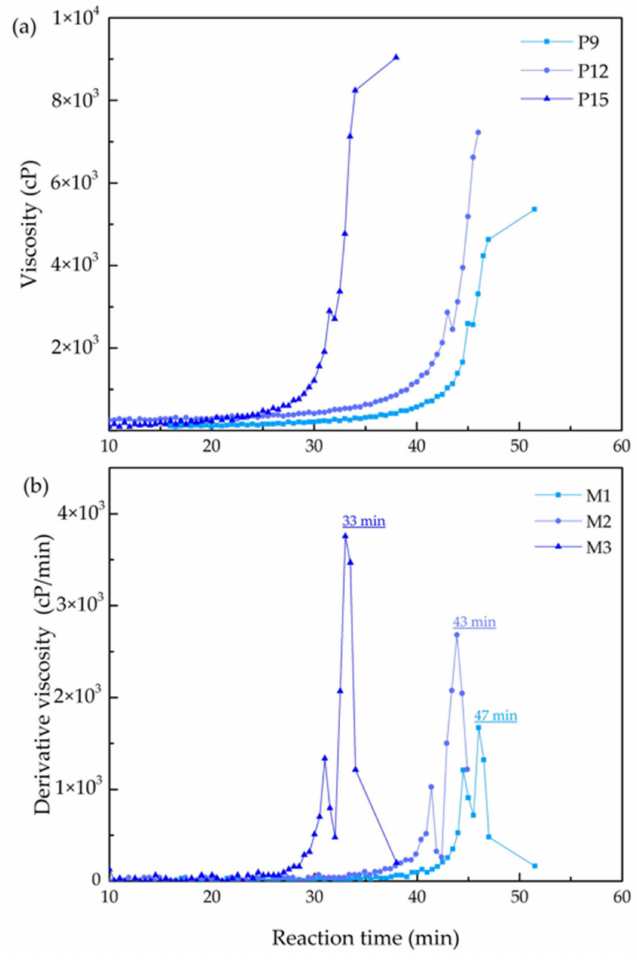
Figure 1. Time dependences of the ( a ) viscosity and ( b ) derivative viscosity of the coating solution in water emulsion during the crosslinking reaction with different TEOS loading ratios (9.4, 12.6, and 15.7 wt.%) at 27 ◦